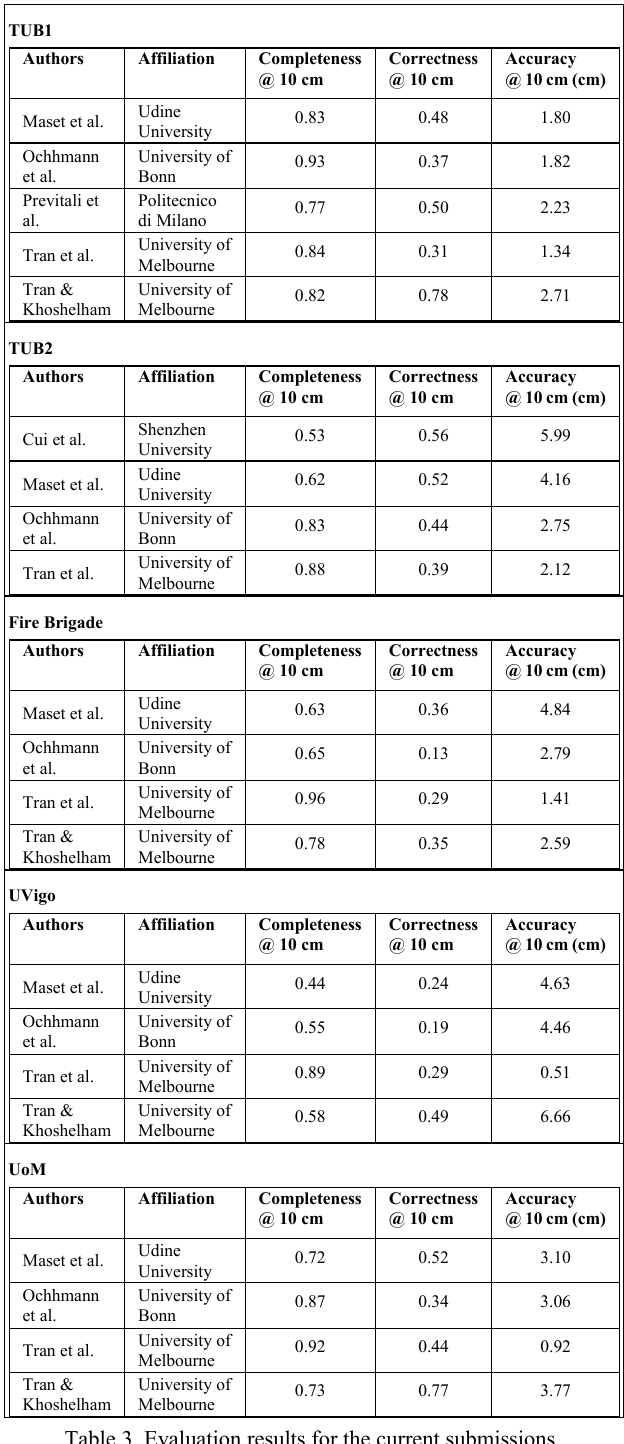
Table 3. Evaluation results for the current